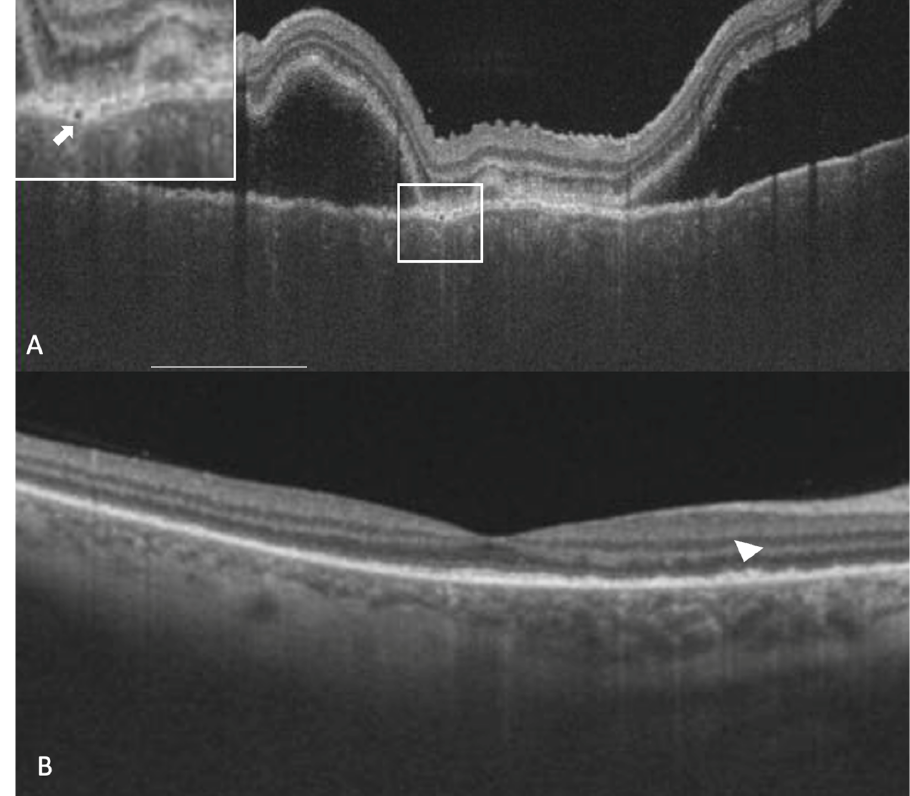
Figure 3. A 26-year-old lady with a diagnosis of acute Vogt-Koyanagi-Harada disease. The right eye shows sub-retinal fluid, thickened choroid, a thickened retinal pigment epithelium (RPE) and an RPE vacuolation (white arrow in the white box inset at the top left corner) in the vertical optical coherence tomography scan ( A ). After the resolution of sub-retinal fluid, persistent deposits over RPE could be noticed (arrowhead) ( B ).